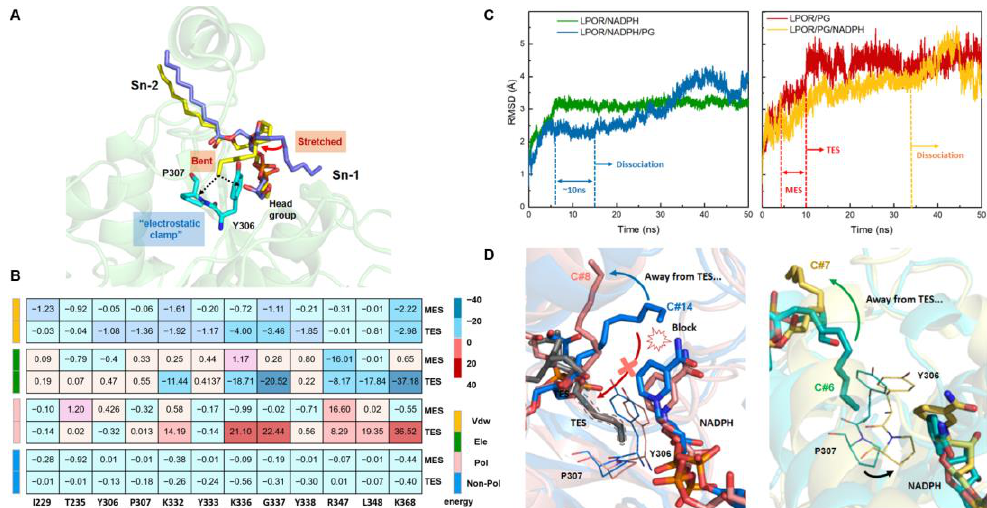
Figure 7. ( A ) The conformational transition extracted in LPOR/PG simulation. The PG is shown in stick with blue and yellow in MES and TES conformations, respectively. ( B ) The heat map of the decomposition of LPOR/PG in the binding pocket. The shades of red and blue represent the magnitude of BFE, respectively, and the energy items of electrostatic energy (ele), van der Waals (vdW), nonpolar, and polar contributions to solvation (sol) are shown in different color. ( C ) The RMSD curves for two binding orders. The NADPH (left) or PG (right) preferentially combined with LPOR, respectively. ( D ) Superimposition of the binding mode represented by PG binding mode cluster in LPOR/NADPH/PG (left) and in LPOR/PG/NADPH (right) with different conformations. Below each binding mode illustration, the ranking number of the binding mode corresponding to (Table S11 and S12) are listed. The TES conformation is obtained by manual alignment as a